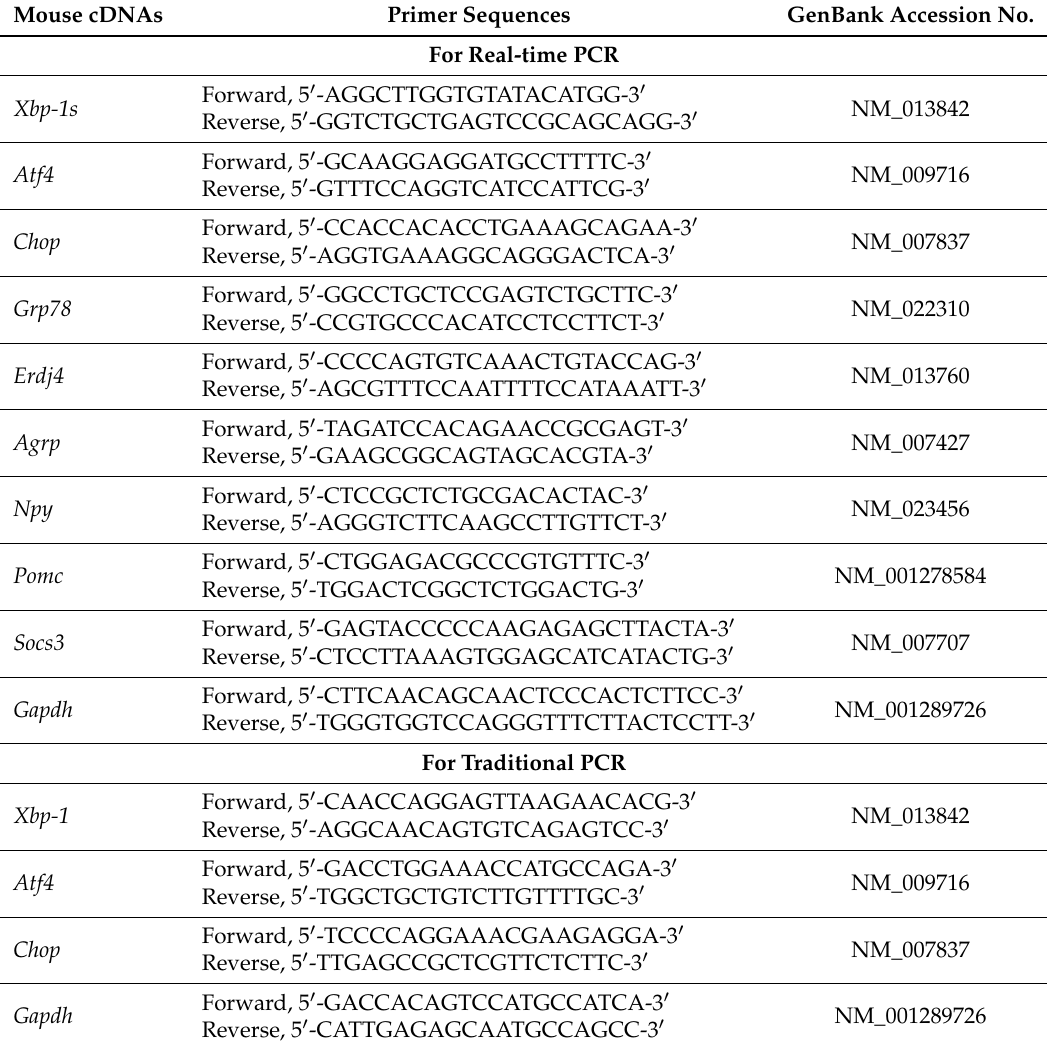
Table 1. DNA primers for